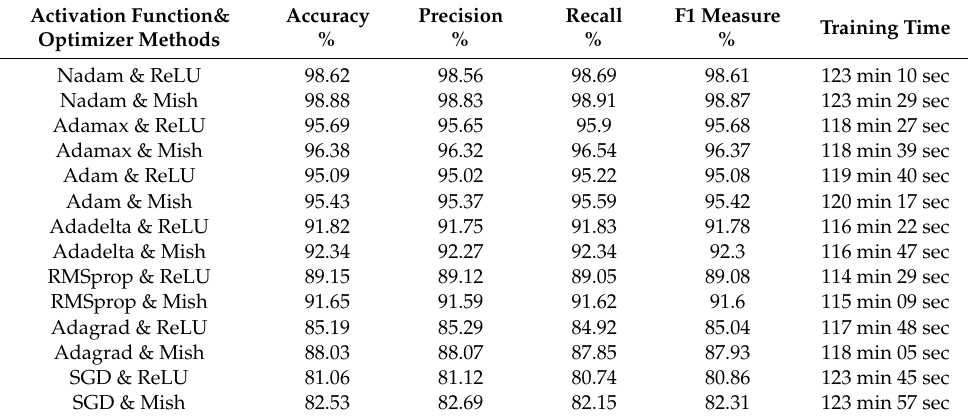
Table 5. The comparative performance of DenseNet-121 with Mish and ReLU using di ff erent optimizer